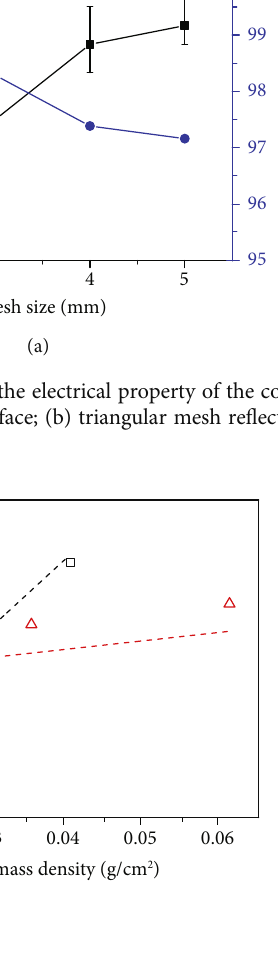
Figure 8: E ff ect of surface mass density on the re fl ection coe ffi cient of the continuous fi ber reinforced thermoplastic composites re fl ecting